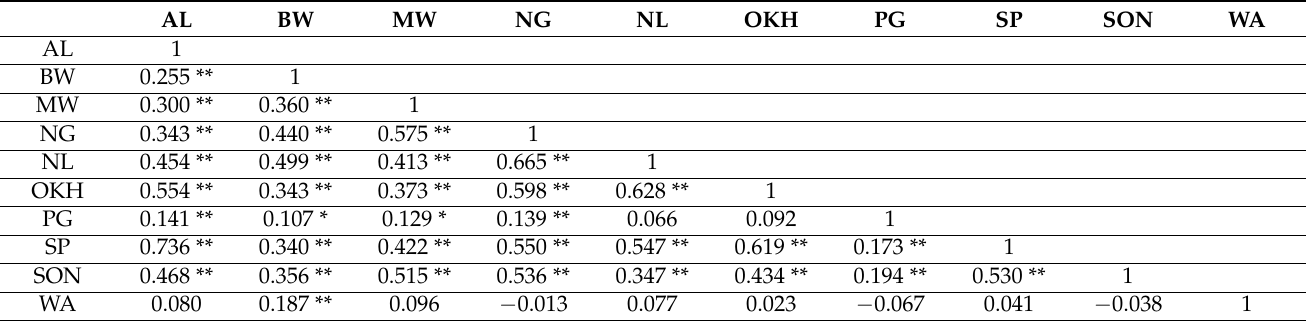
Table 3. Correlation between the different monitoring stations during the pandemic period.